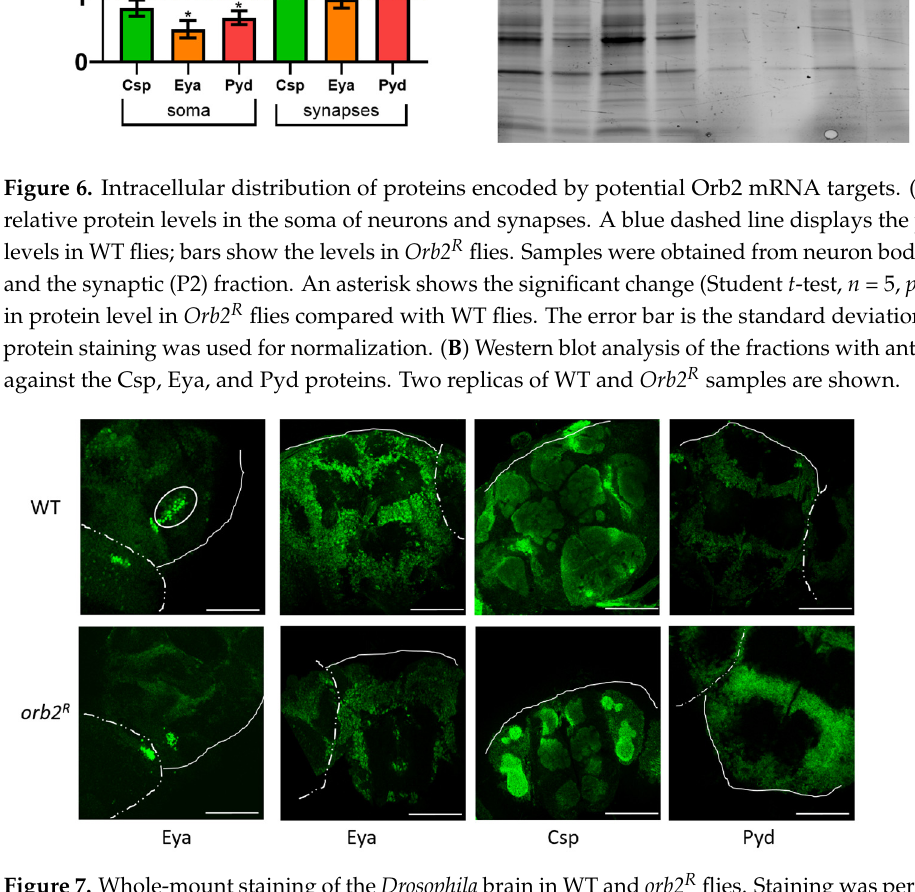
Figure 6. Intracellular distribution of proteins encoded by potential Orb2 mRNA targets. ( A ) The relative protein levels in the soma of neurons and synapses. A blue dashed line displays the protein levels in WT flies; bars show the levels in Orb2 R flies. Samples were obtained from neuron bodies (LP) and the synaptic (P2) fraction. An asterisk shows the significant change (Student t -test, n = 5, p < 0.05) in protein level in Orb2 R flies compared with WT flies. The error bar is the standard deviation. Total protein staining was used for normalization. ( B ) Western blot analysis of the fractions with antibodies against the Csp, Eya, and Pyd proteins. Two replicas of WT and Orb2 R samples are shown.